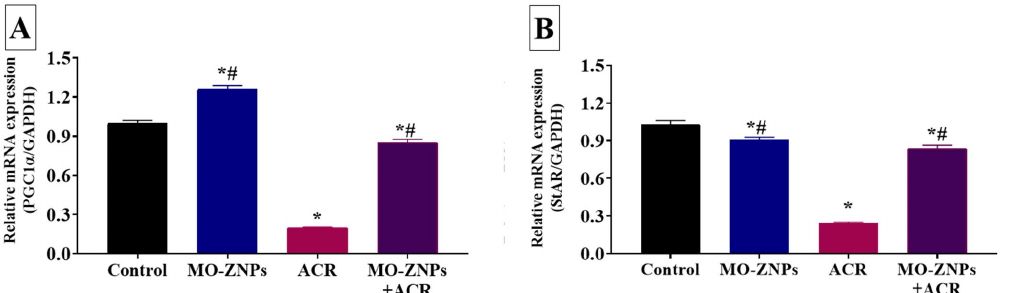
Figure 7. Effect of acrylamide (ACR) delivered orally (20 mg/kg) and/or zinc oxide nanoparticles synthesized by M. oleifera (MO-ZNPs) delivered orally (10 mg/kg bwt/day, 60 days) on mRNA expression of ( A ) peroxisome proliferator-activated receptor gamma coactivator 1-alpha (PGC-1 α ) and ( B ) steroidogenic acute regulatory protein (StAr) in the testicular tissues of male rats. Bars represent the mean ± SE. n = 10 replicates/treatment. * p < 0.05 vs. control. # p < 0.05 vs. ACR.